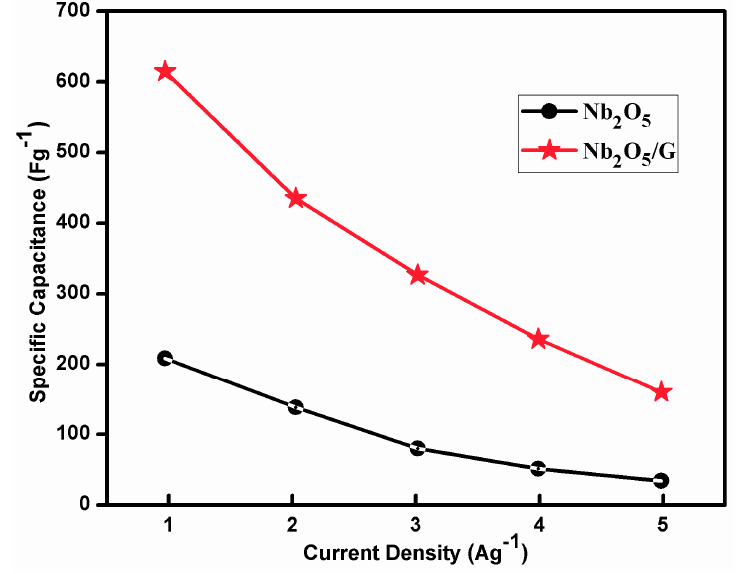
Figure 11. Specific capacitance of pure and composite electrode material at different current density values.